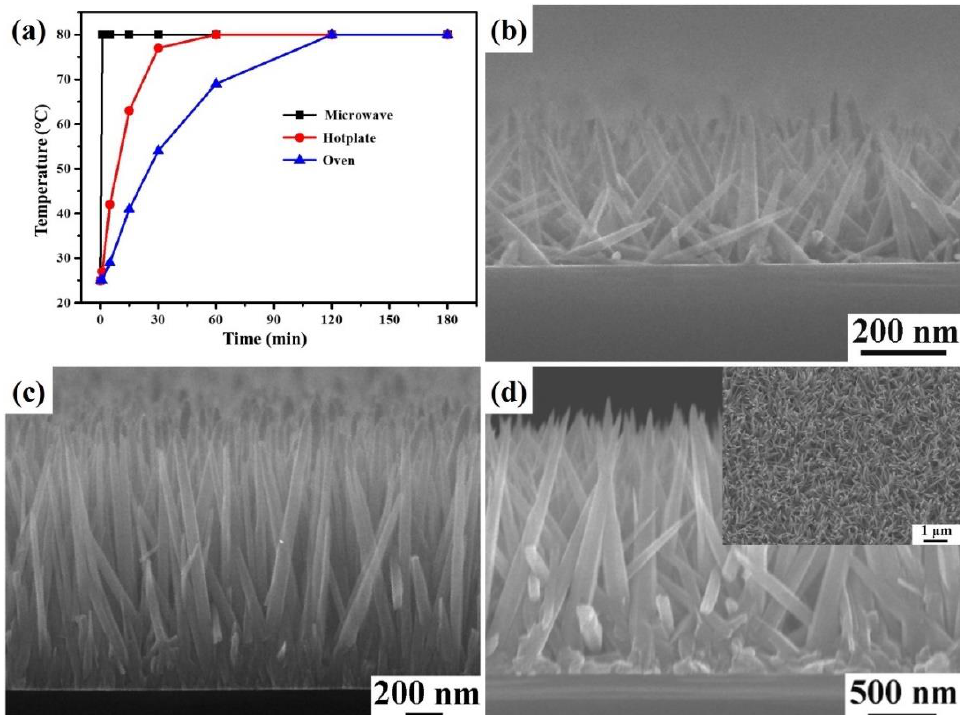
Figure 2. ( a ) The heating curves of microwave irradiation oven, hotplate, and oven. ( b – d ) The cross- sectional FESEM images of the ZnO nanoneedle arrays were fabricated on the silicon substrates with the ZnO seed layer at different reaction times. The reaction times are ( b ) 1, ( c ) 15, and ( d ) 60 min, respectively.